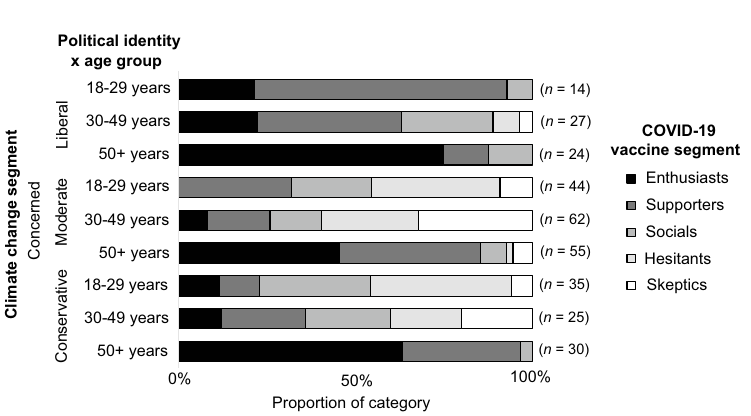
Figure 6. Vaccine segment distributions within the Concerned climate segment for politically conservative, moderate, and liberal across each age